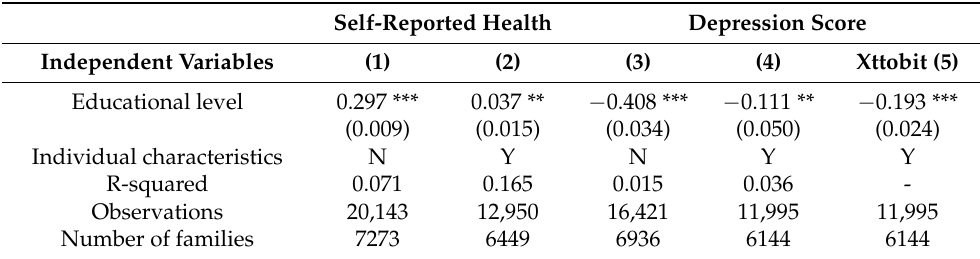
Table 4. The impact of education on health